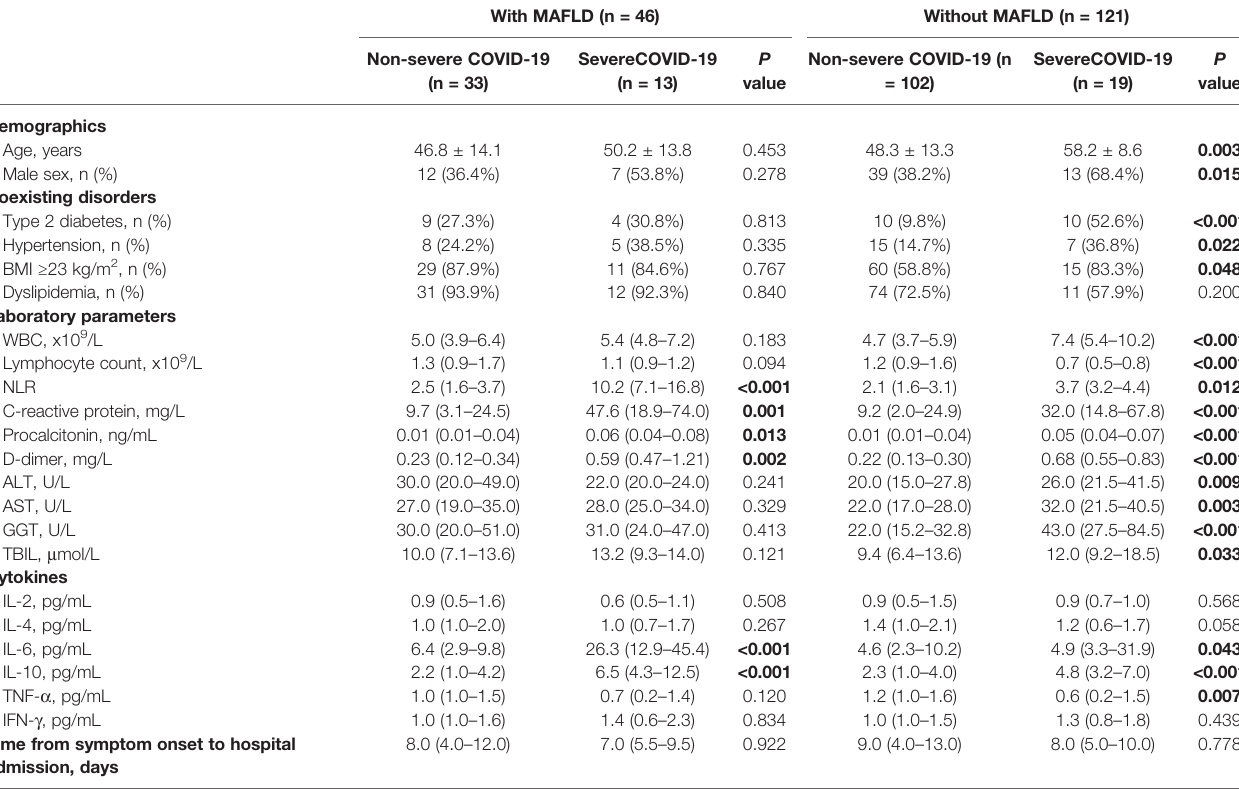
TABLE 2 | Baseline characteristics of COVID-19 patients, strati fi ed by both COVID-19 severity and MAFLD status.